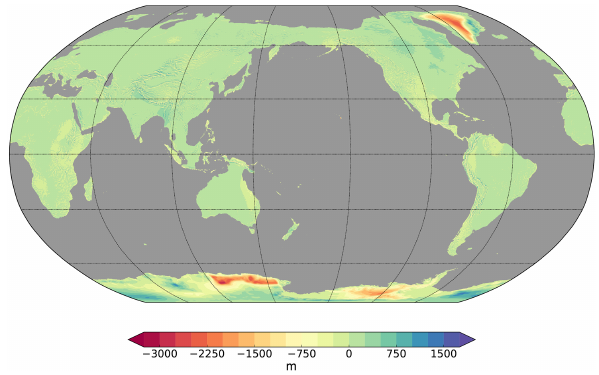
Figure 1. The topography anomaly field, which when superim- posed on our local modern-day topography, results in the PRISM4 mid-Pliocene